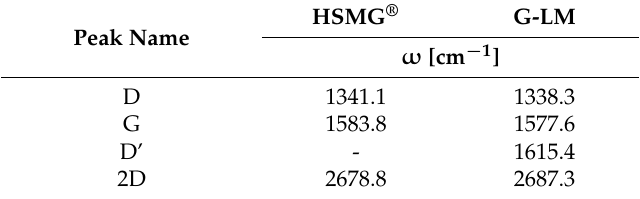
Table 1. Names of Raman peaks identified in the studied graphene structures with their specific frequencies.